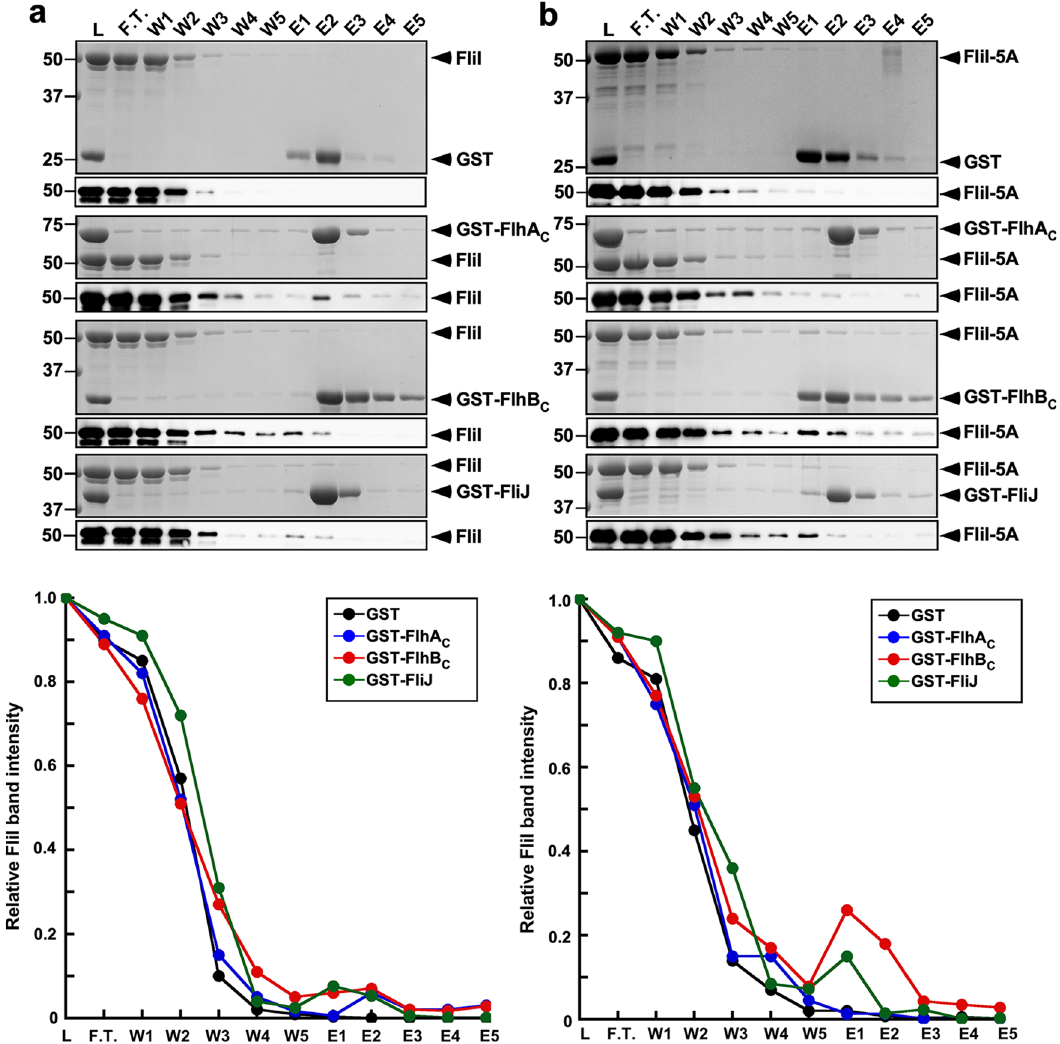
Fig. 7 Effect of the fl iI-5A mutation on the interactions of FliI with FlhA C , FlhB C , and FliJ. a Puri fi ed His-FliI or b His-FliI-5A was mixed with GST-FlhA C , GST-FlhB C , or GST-FliJ, and then each mixture (L) was dialyzed overnight against PBS, followed by GST af fi nity chromatography. Flow through fraction (F. T.), wash fractions (W), and elution fractions (E) were analyzed by CBB staining (upper panel) and immunoblotting with anti-FliI antibody (lower panel). The regions of interest were cropped from original CBB-stained gels and immunoblots shown in Supplementary Fig. 12. The average band intensity of FliI in the L lane was set to 1.0, and then relative band intensity of each lane was calculated. These data are average of three independent experiments. Standard deviations were within